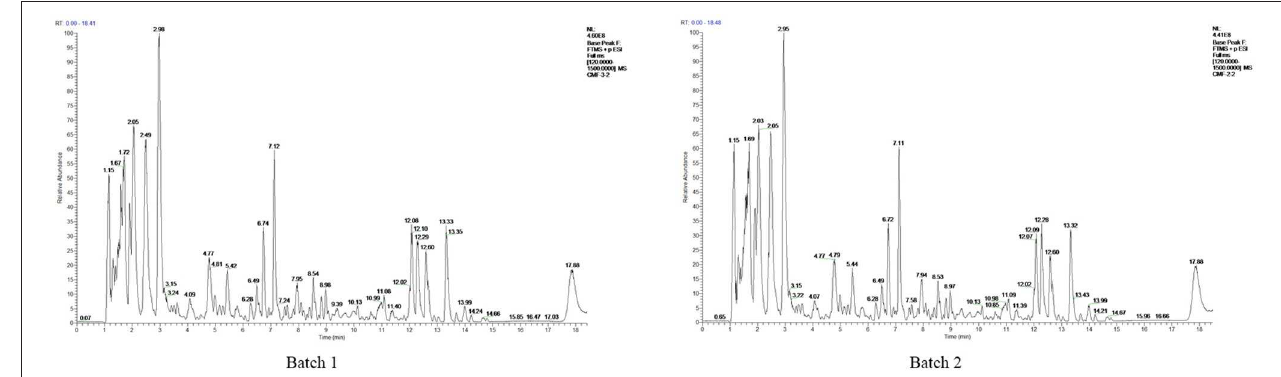
FIGURE 1 | HPLCprofile of two batches of CMF. The chemical fingerprint of CMF batch #1 and batch #2 was measured by HPLC